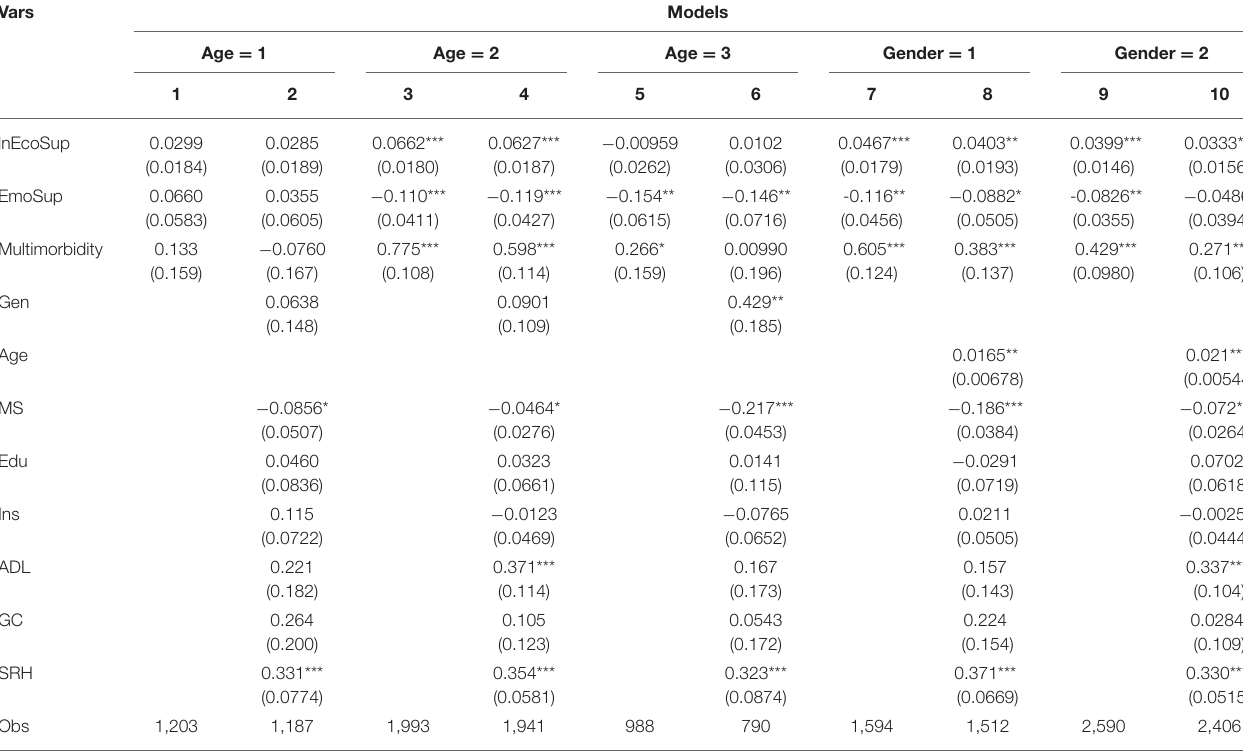
TABLE 5 | Heterogeneity analysis